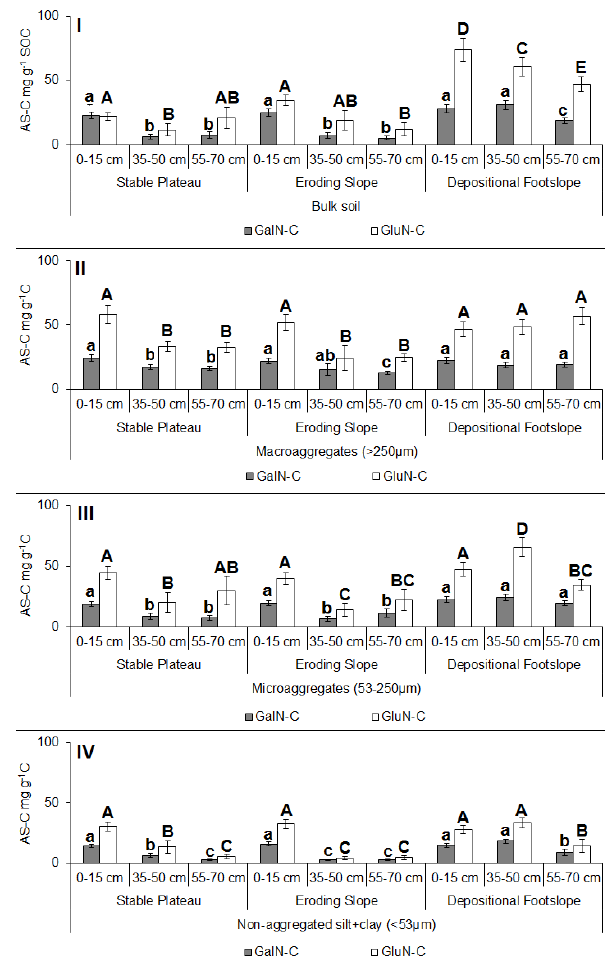
Figure 5. AS per unit SOC in the bulk soil (I) and the fractions (II– IV) along the slope and for different depths. Different letters above bars indicate a significant difference ( p <0.1, for the two different AS and the bulk soil and three fractions separately as indicated by differences in font